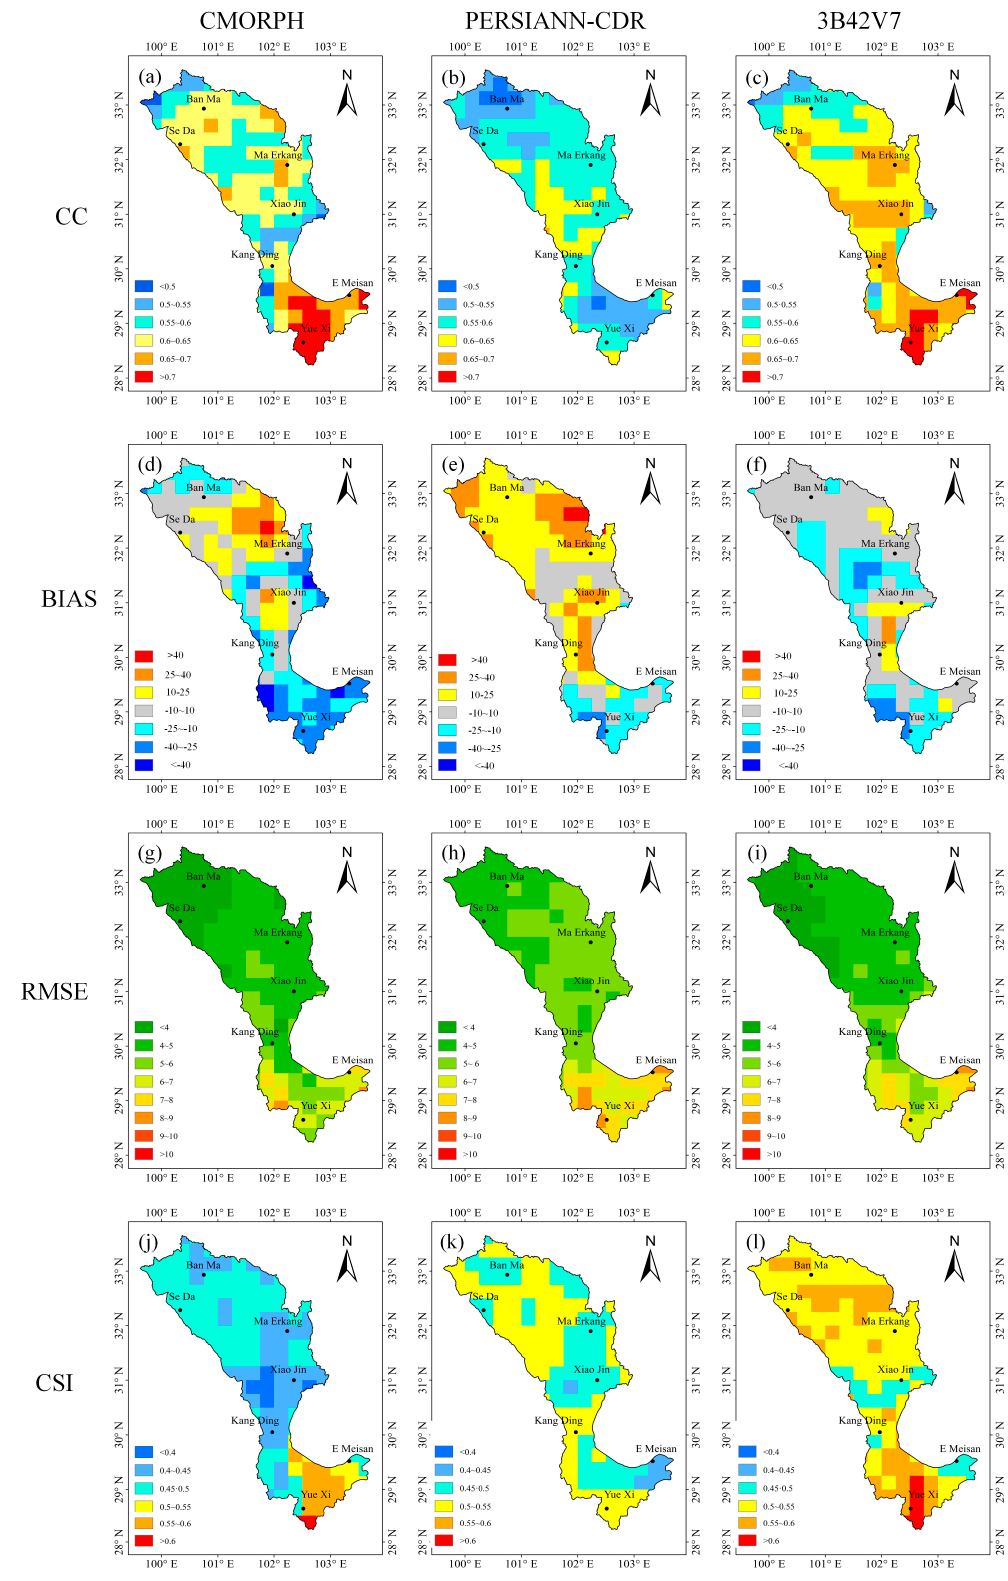
Figure 4. Spatial distributions of statistical metrics for CMORPH (first column), PERSIANN-CDR (second column) and 3B42V7 (third column): ( a – c ) CC, ( d – f ) BIAS, ( g – i ) RMSE and ( j – l ) CSI.